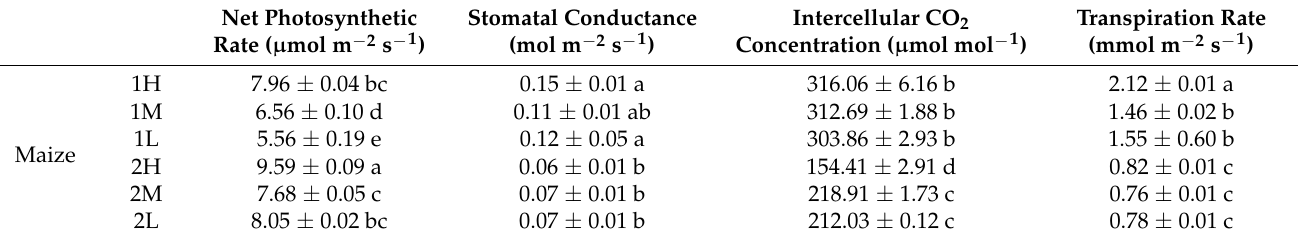
Table 1. The photosynthetic parameters of maize seedlings under different light conditions.